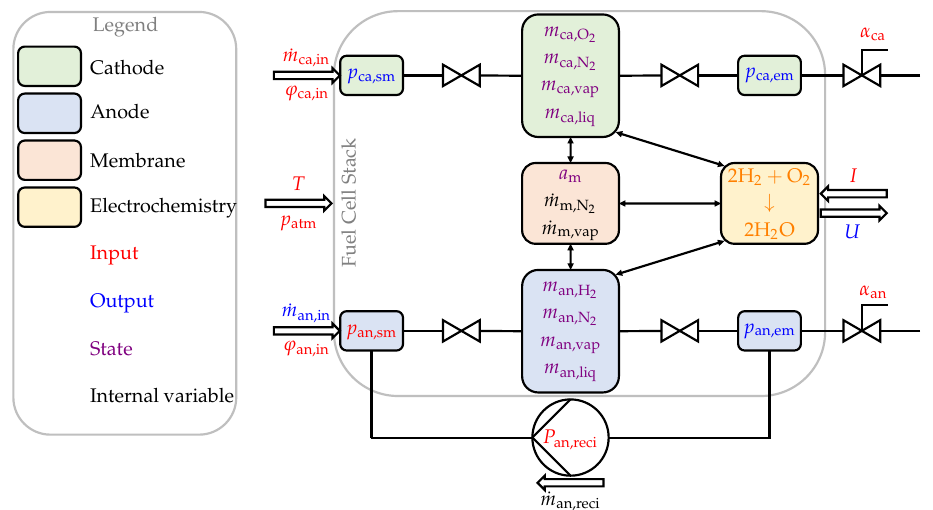
Figure 1. Schematic overview of the PEMFC stack model structure [18].